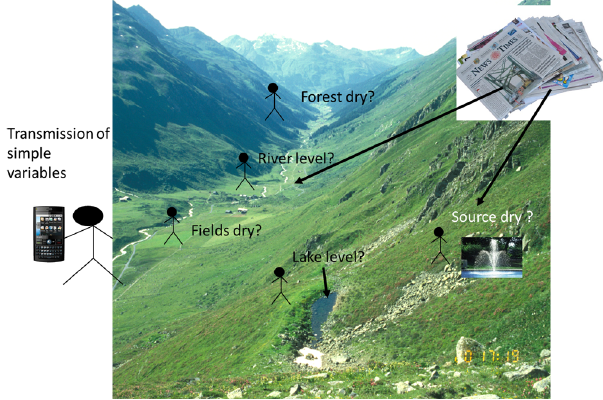
Fig. 4. Involving stakeholders in drought forecasting and as “cli- mate change witnesses”. Stakeholders can contribute to describ- ing different natural characteristics such as presence or absence of springs and running tap water, lake and river levels, state of fields and forests. Local newspapers can act as archives. The variables could be transmitted via mobile phone.